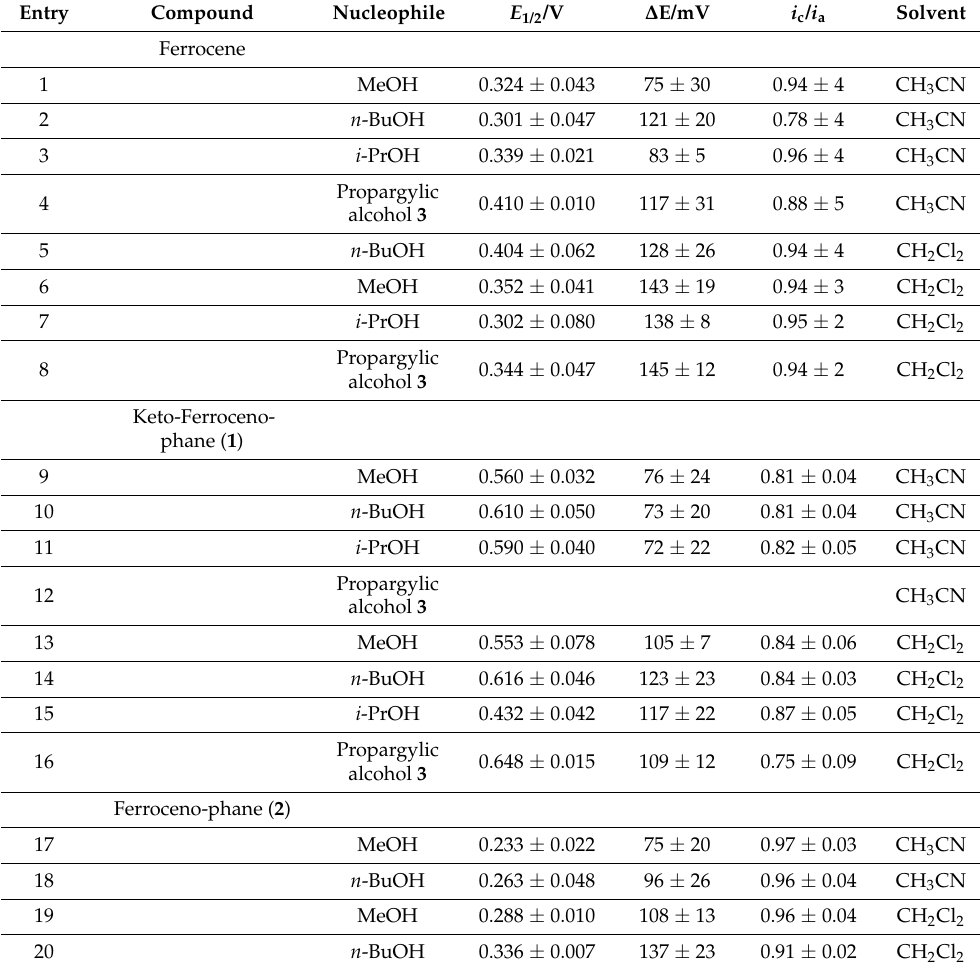
Table 3. Cyclic Voltammetry in presence of alcohol